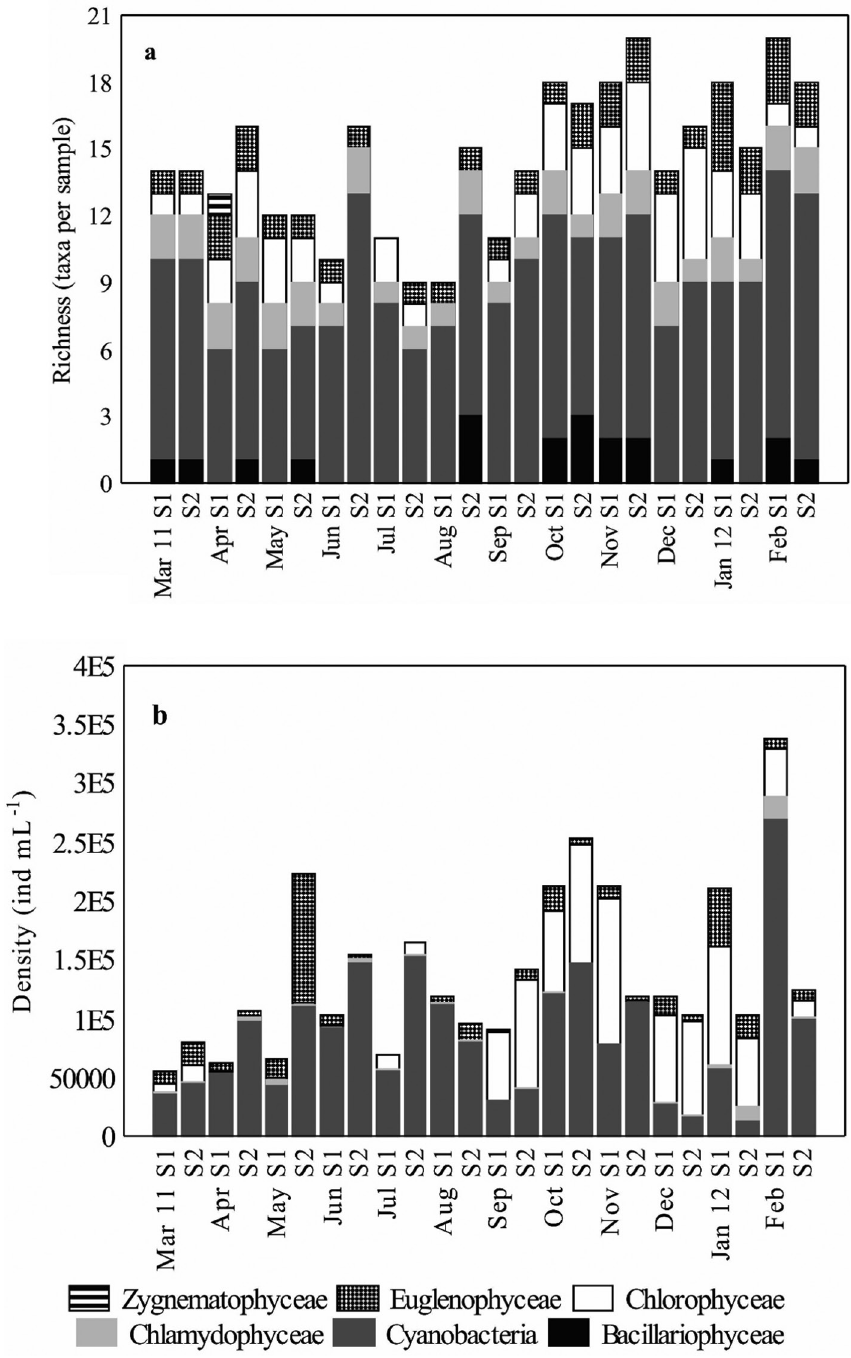
Figure 3. Temporal and spatial variation of the richness (a) and density (b) phytoplankton in stabilization